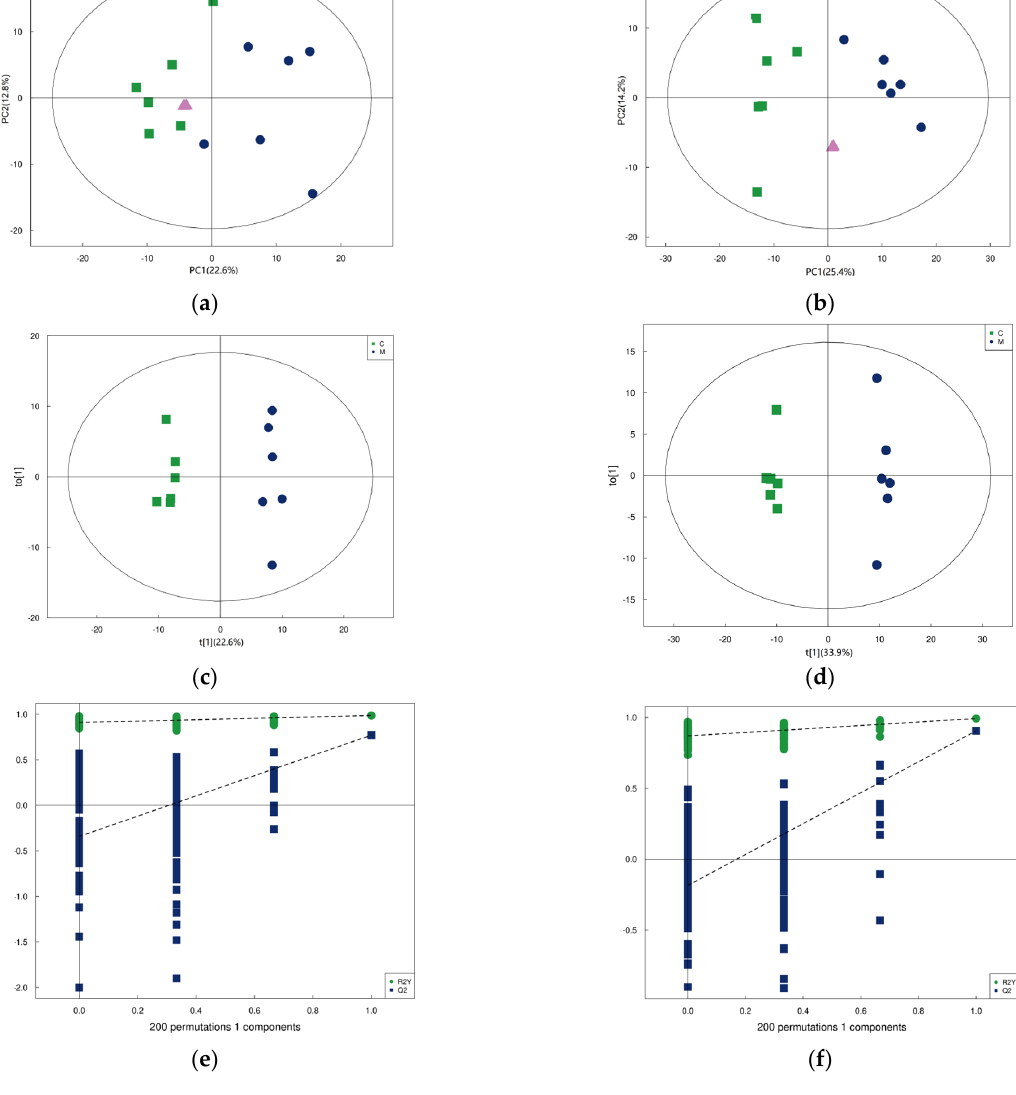
Figure 4. ( a ) PCA score plots of the metabolites in yak colostrum milk, mature milk, QC in positive ionization mode. Green, blue, and red represent the samples of yak colostrum milk, mature milk, QC, respectively. ( b ) PCA score plots of the metabolites in the yak colostrum milk, mature milk, QC in negative ionization mode. ( c ) OPLS − DA score plots of the metabolites in the yak colostrum and mature milk in positive ionization mode. Green and blue represent the samples of yak colostrum milk and mature milk, respectively. ( d ) OPLS − DA score plots of the metabolites in the yak colostrum and mature milk in negative ionization mode. ( e ) Permutation test of OPLS − DA in positive ionization mode. ( f ) Permutation test of OPLS − DA in negative ionization